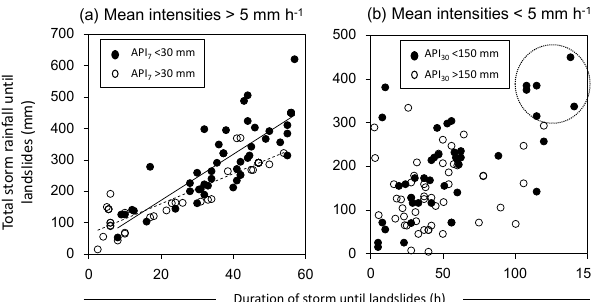
Figure 8. Total storm rainfall–duration relationships with different API conditions: (a) mean intensities > 5mmh − 1 (b) mean inten- sities > 5mmh − 1 ; the dashed circle indicates six large and long duration events that probably triggered landslides due to an accu- mulation of pore water pressure during the individual